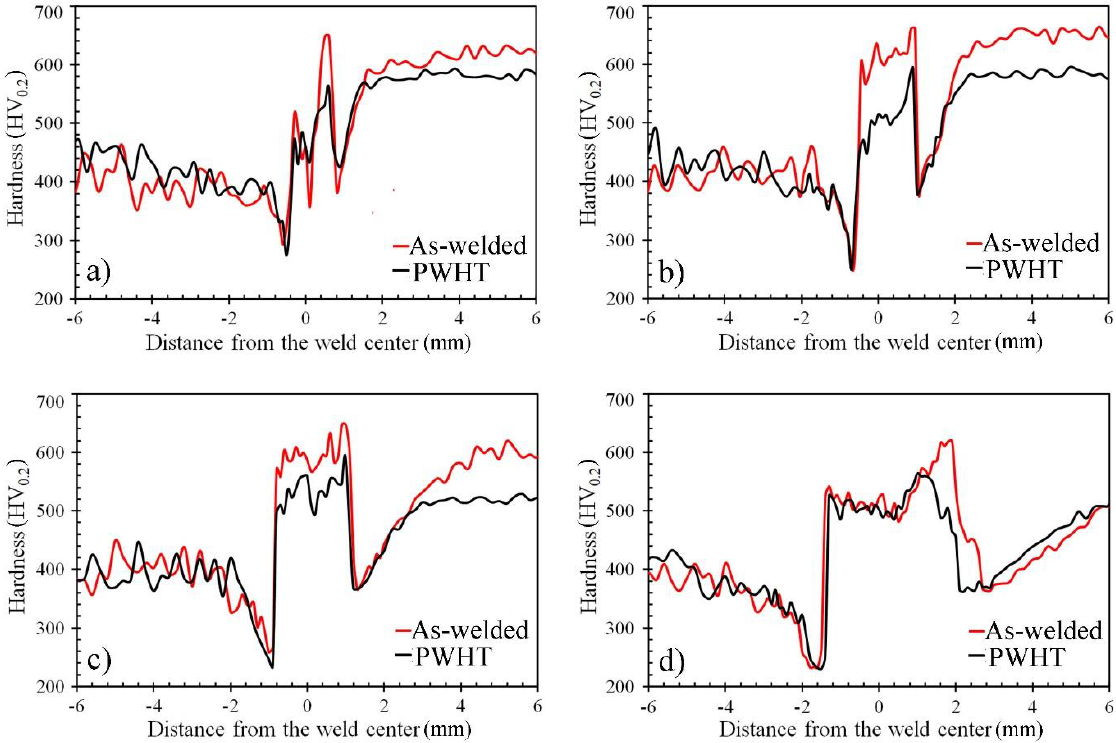
Figure 11. The hardness profiles of the dissimilar laser-welded butt joints between the ASS and AR600 at different EIs without and with post-welding heat treatment (PWHT) at 250 °C for 1 h: ( a ) 50 J/mm; ( b ) 100 J/mm; ( c ) 160 J/mm; ( d ) 320 J/mm.